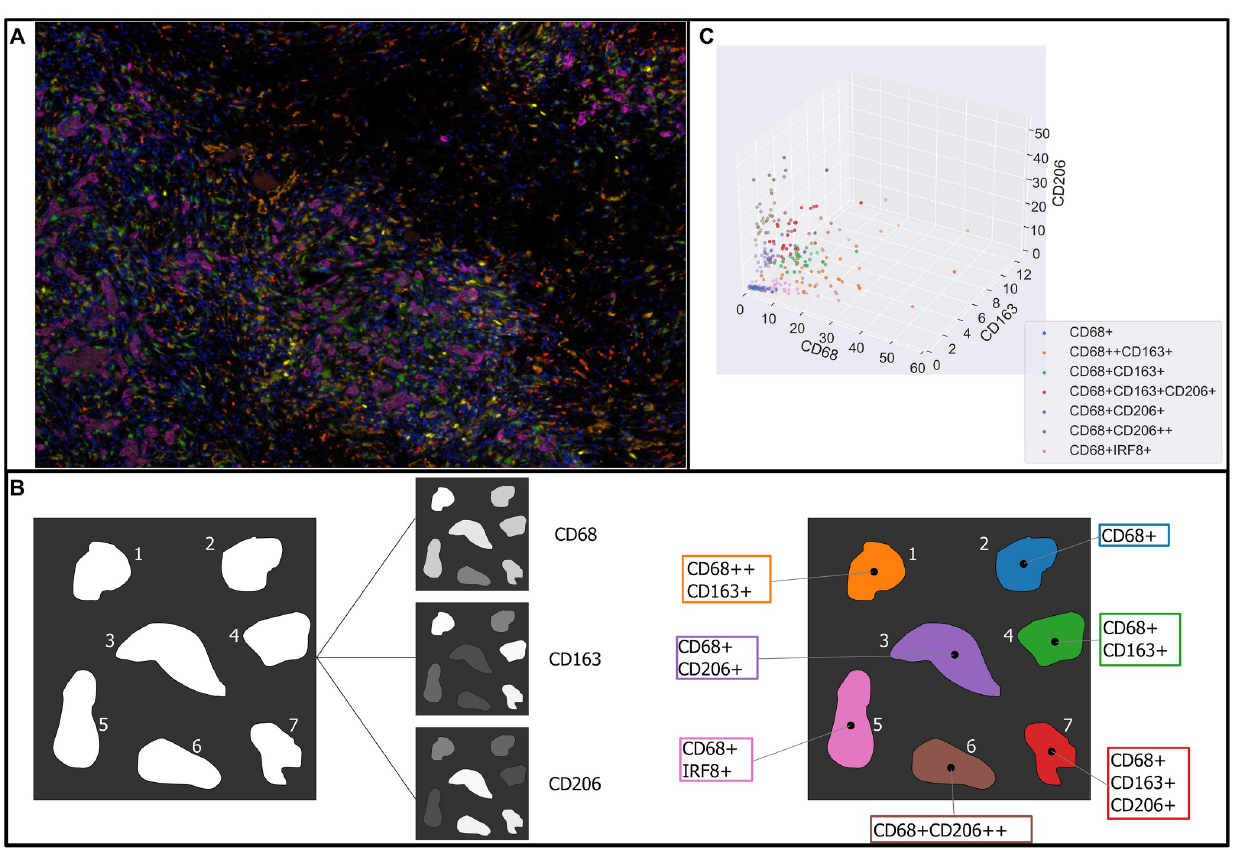
Fig 1. Typical process for analysing macrophage phenotypes in multiplex imaging. A: A multiplex image showing macrophages of varying phenotypes, reproduced from Fig 1b in [12]. Expression levels of different functional markers (e.g., CD68, CD163, CD206) are shown as differing intensities of separate stains, visualised as a false-colour image. (Key: Orange: CD68+CD206++, Brown: CD68+CD206+, Green: CD68+, Yellow: CD68+IRF8+, Dark red: CD68+ +CD163+, Red: CD68+CD163+, and Purple: CD68+CD163+CD206+). B: Schematic indicating how continuous stain intensities represented in a multiplex image are converted into different categories indicating macrophage phenotype. In this example, cell colours in the multiplex image are converted into stain intensities for CD68, CD163 and CD206. Thresholds are assigned to each stain to distinguish whether a cell is negative, positive, or extremely positive, for each stain. Each macrophage is then assigned one of 7 different potential phenotypes, based on combinations of positivity or negativity for each stain. C: Data reproduced from Fig 1h in [12]. Points represent the average stain intensity of CD68, CD163, and CD206 measured in macrophages assigned to each of the seven phenotype subtypes in each of n = 35 patients. Note that macrophages from the same subtype in different patients have differing levels of intensity of each marker, so the same categorical label may be applied to macrophages with a wide range of continuous expression levels. Fig 1 contains elements adapted from Fig 1 of https://doi.org/10.1038/s41467–019-11788-4, which is published under a Creative Commons Attribution 4.0 International License.